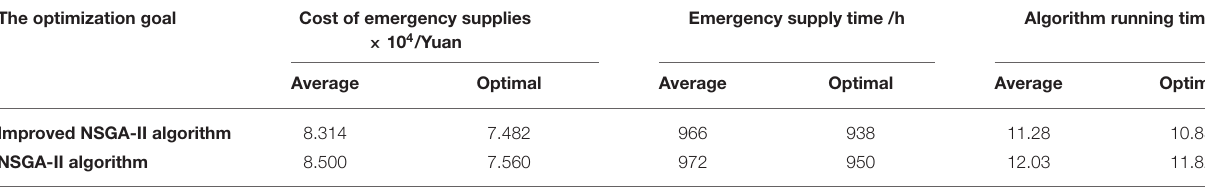
TABLE 5 | Improved NSGA-II algorithm performance comparison.